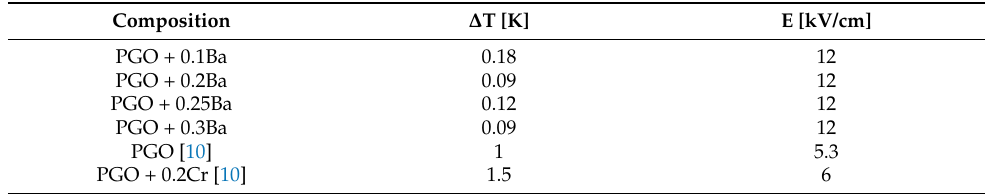
Table 3. A comparison of the values of the maximum electrocaloric temperature change ∆ T under the electric field E for the PGO + xBa (x = 0.1, 0.2, 0.25, and 0.3), PGO, and PGO + xCr (x =